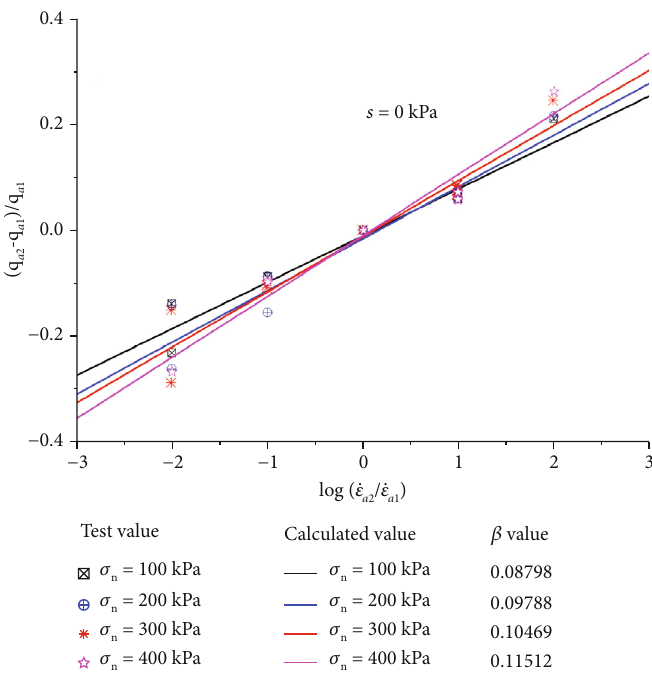
Figure 7: β value of reticulate red clay with di ff erent net con fi ning pressure ( s = 0kPa ).